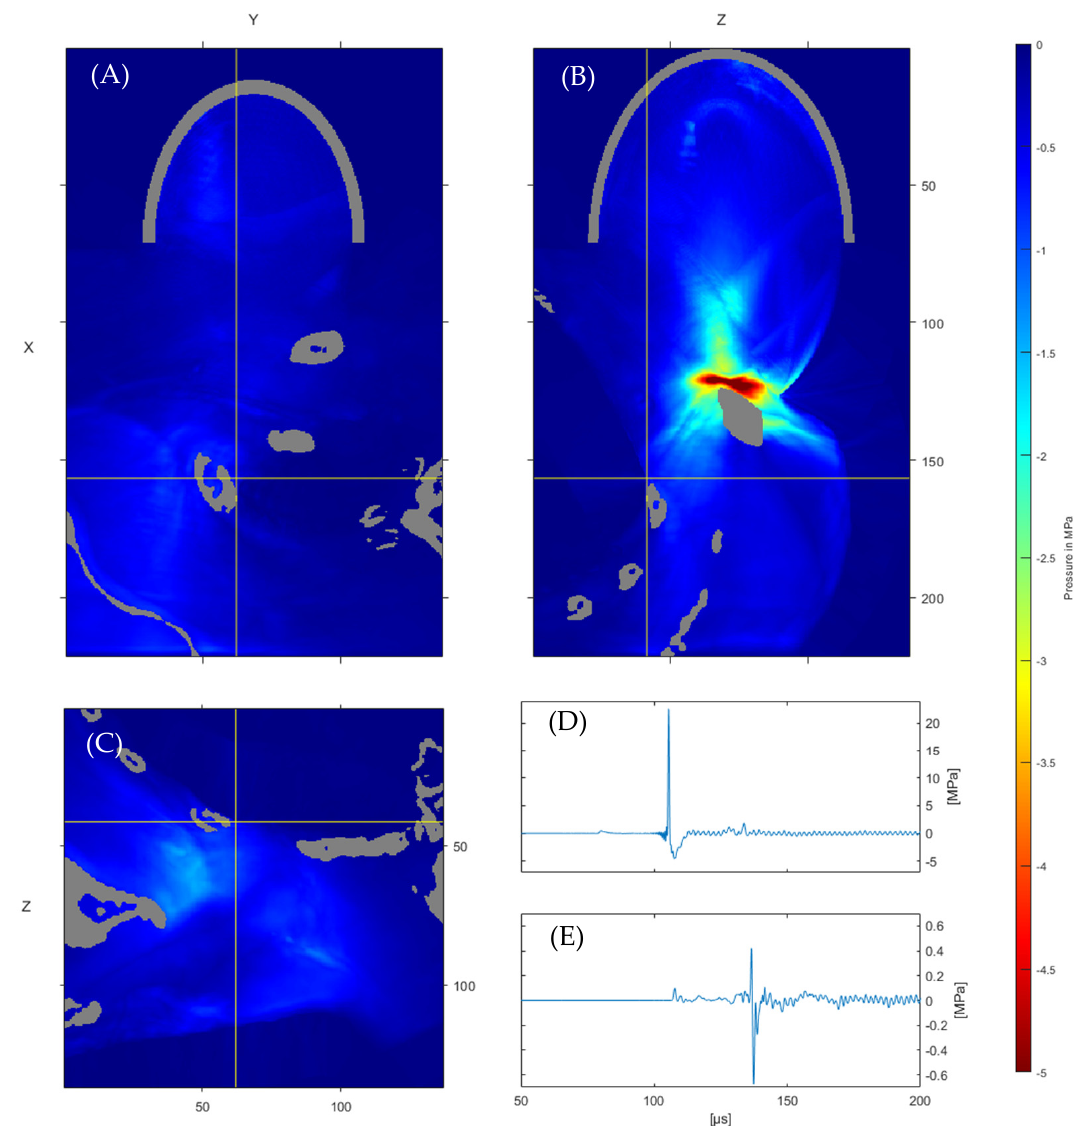
Figure 4. Peak tensile pressure distribution ( A – C ) with spatial units (mm) and waveform at the reference focal point ( D ), and the indicated position of maximum tensile stress at lung surface ( E ).